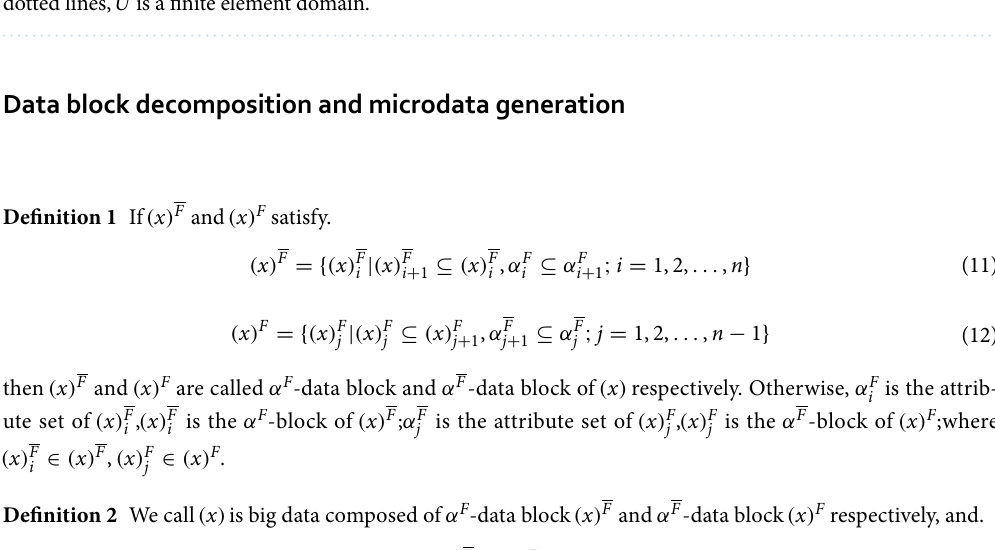
F F Figure 1. X and X are the internal P-sets and outer P-sets generated by X respectively, X F F F , X F ) P-Sets ( X ; X and X are represented by solid lines, and finite ordinary element set X is represented by dotted lines, U is a finite element